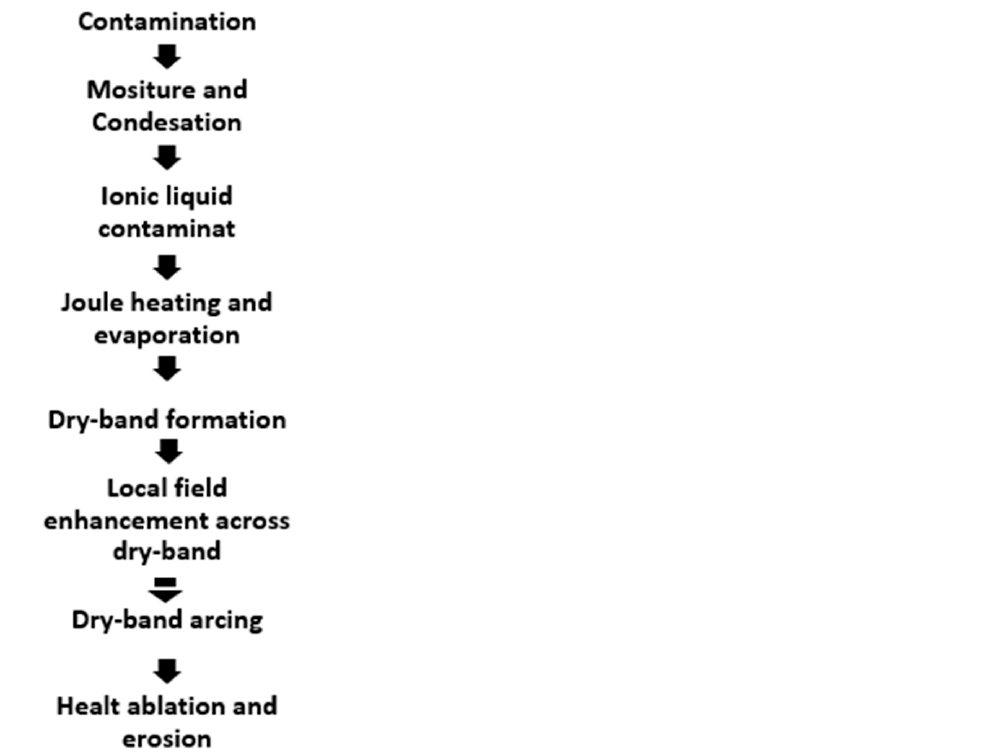
Figure 1. Erosion mechanism on the surface of silicone rubber outdoor insulation housing.